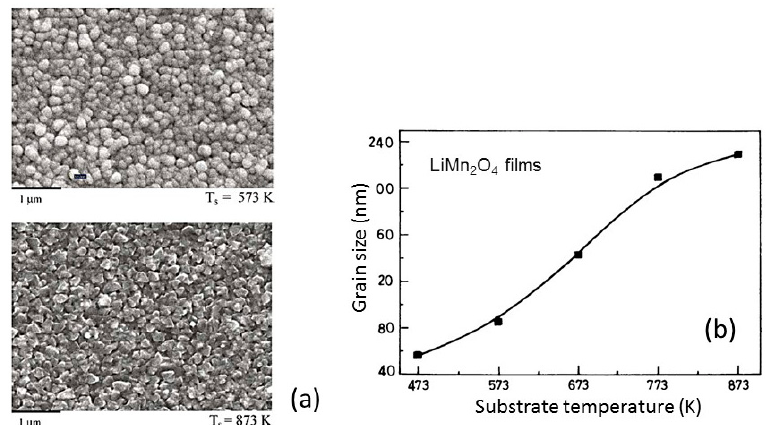
Figure 8. ( a ) SEM images of LiMn 2 O 4 films deposited at T s = 300 °C and T s = 600 °C. ( b ) The